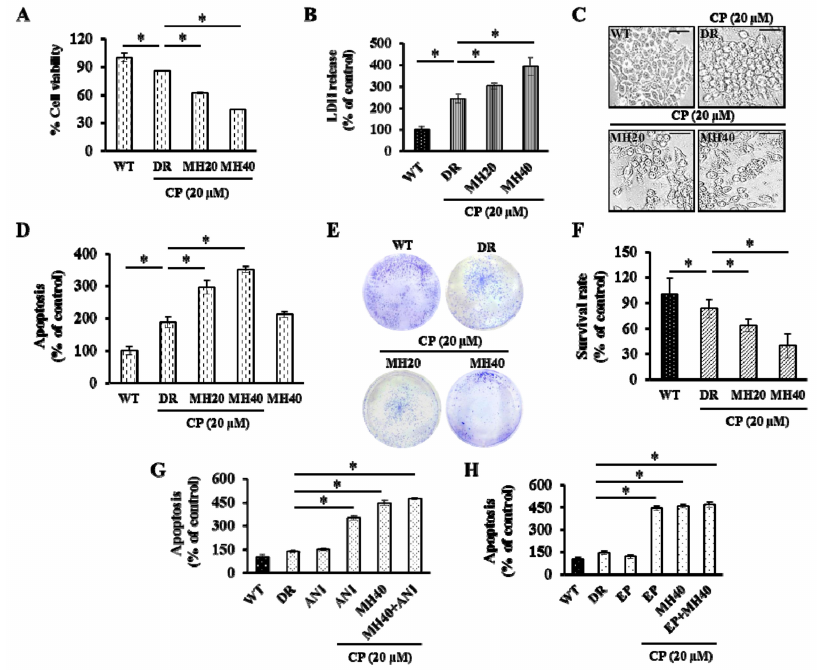
Figure 4. MH promotes apoptosis of HepG2 DR cells against CP. ( A ) HepG2 DR cell viability was measured after drug treatment by the MTT assay. ( B ) Total cellular LDH release was measured by the LDH assay. ( C ) Representative microscopic images of the morphology of HepG2 WT and HepG2 DR cells after drug treatments (magnification: 200 × ; scale bar: 0.1 mm). ( D ) Percentage of